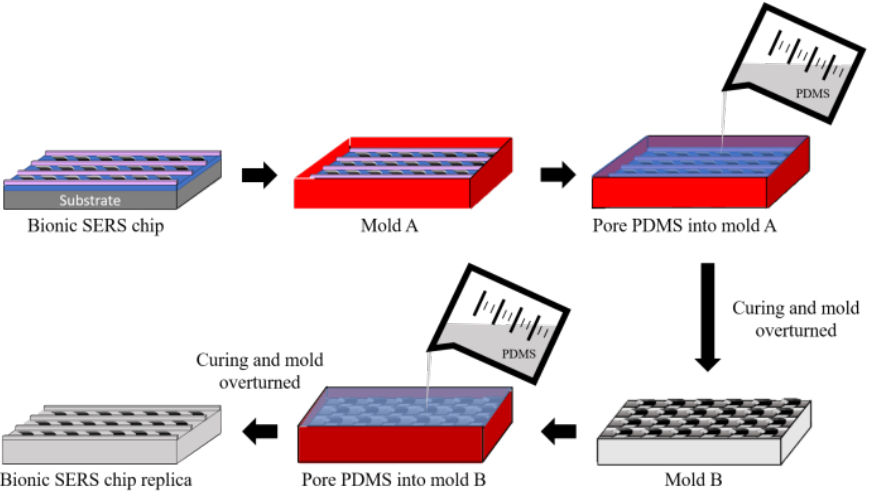
Figure 2. Diagram of the replicated Nepenthes peristome-like structure process by polydime- thylsiloxane (PDMS).